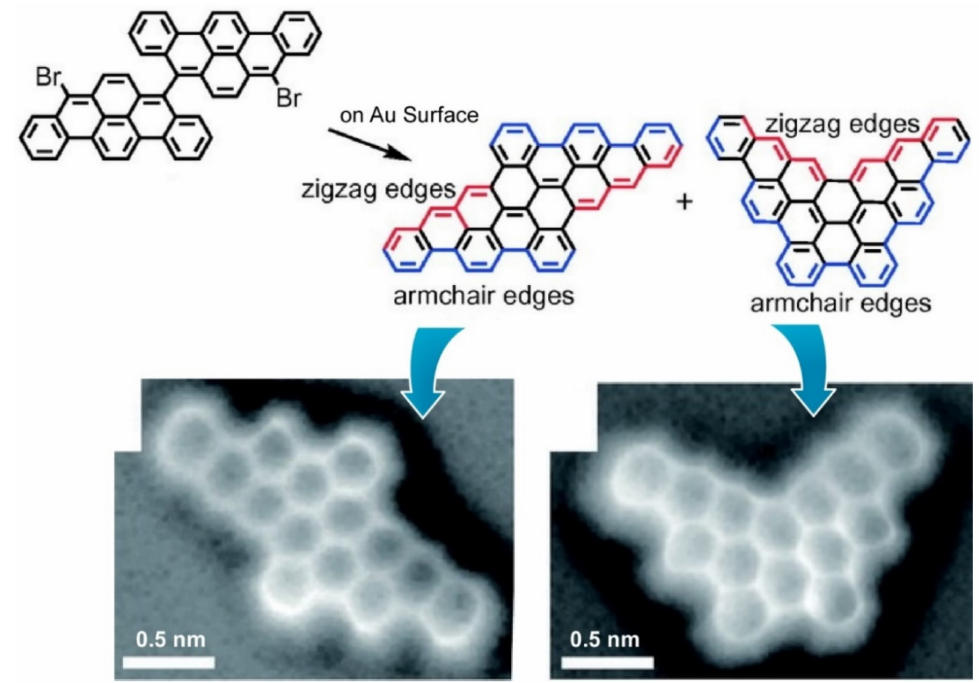
Figure 6. On-surface synthesis and high-resolution observation for parallelogram-shaped diben- zohexacenohexacene ( left ) and butterfly-shaped dibenzopentaphenoheptaphene ( right ) possessing armchair and zigzag edges. Reprinted with permission from Reference [113]. Copyright 2021 Chemical Society of